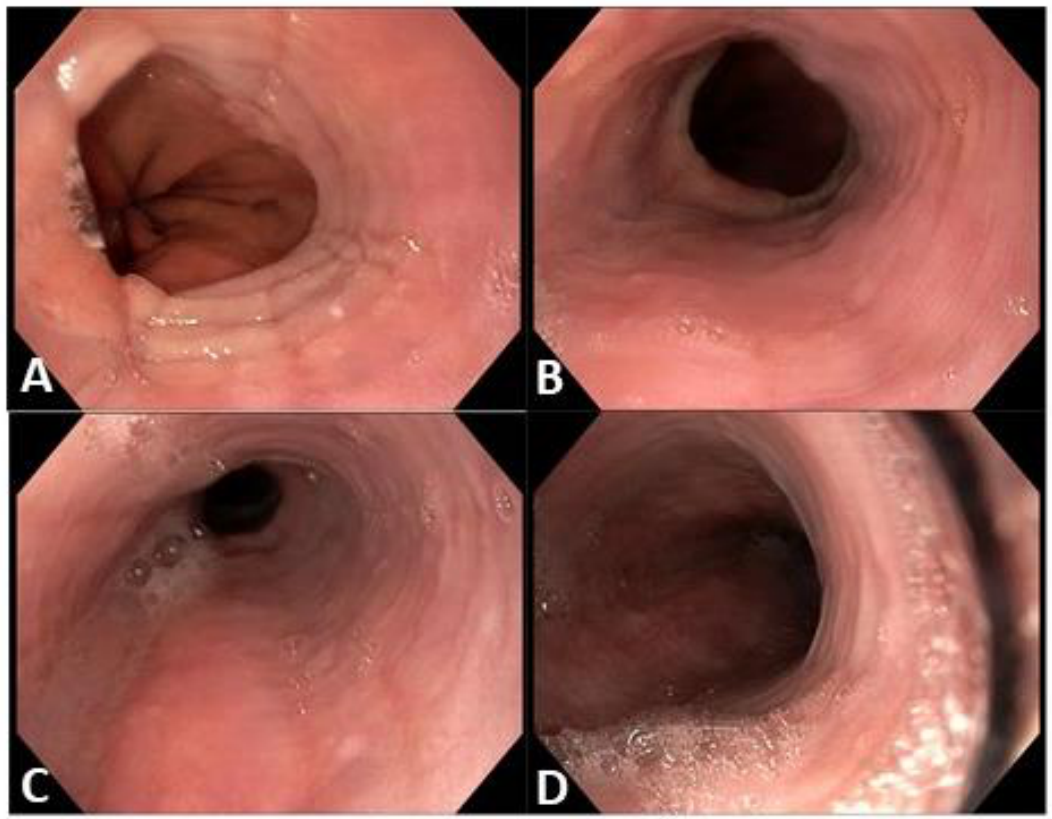
Figure 2: Endoscopic appearance of esophageal mucosa. ( A ) Rings and furrows at the distal esopha- gus, the juxtacardiac tract. ( B ) Rings at the distal esophagus. ( C ) Rings, furrows and exudates at the mid esophagus. ( D ) rings at the proximal